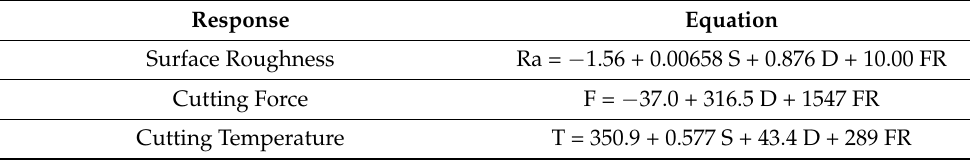
Table 11. Mathematical equations for the measure responses.